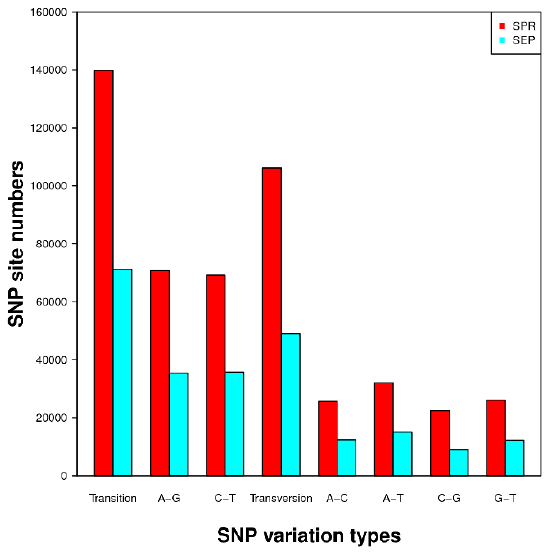
Figure 6. Description and classification of single nucleotide polymorphisms (SNPs) identified in SPR and SEP lines.